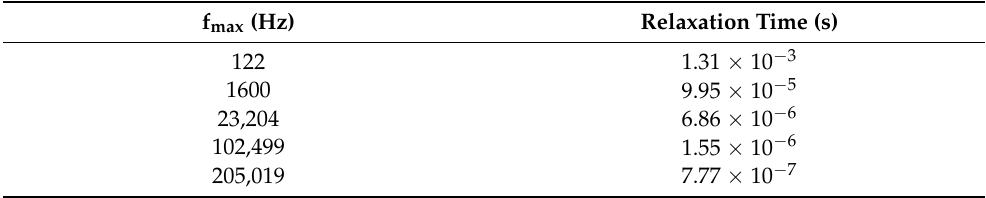
Table 3. Variation of relaxation frequency (f max ) with relaxation time ( τ